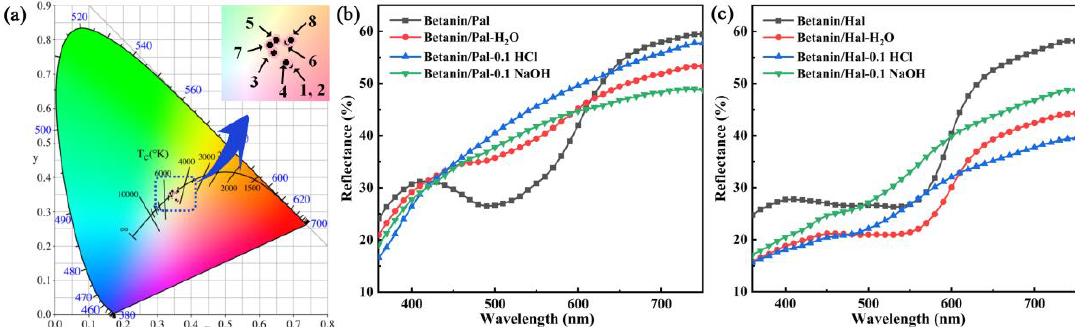
Figure 7. ( a ) Chromatic CIE coordinates and UV-vis di ff use reflectance spectra of ( b ) betanin / Pal and ( c ) betanin / Hal hybrid materials after being treated by distilled water, 0.1 M HCl and 0.1 M NaOH for 24 h (1: Betanin / Pal; 2: Betanin / Hal; 3: Betanin / Pal-H 2 O; 4: Betanin / Hal-H 2 O; 5: Betanin /